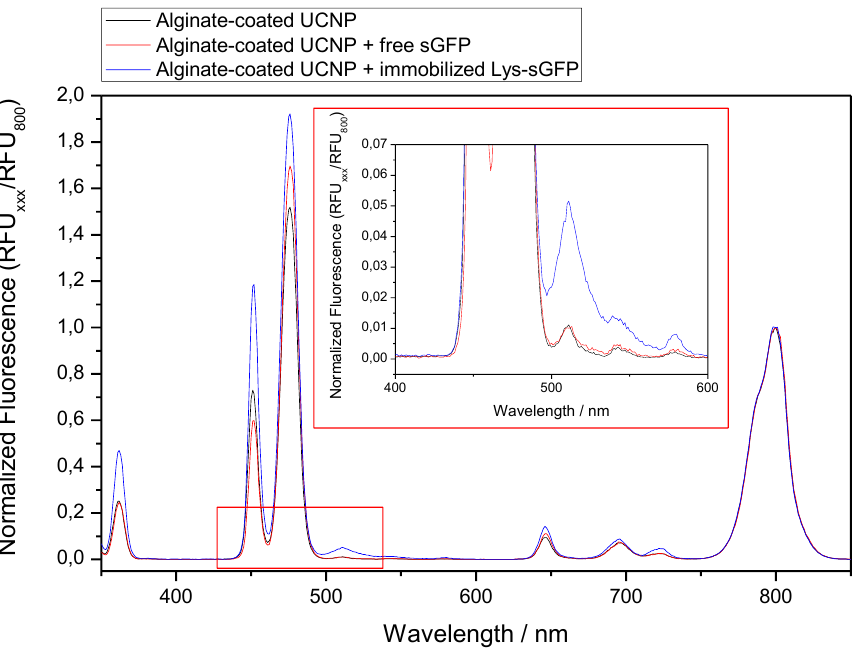
Figure 8. Emission spectra of alginate-coated UCNPs. All the signals were normalized assigning a value of 1 to the peak at 800 nm.